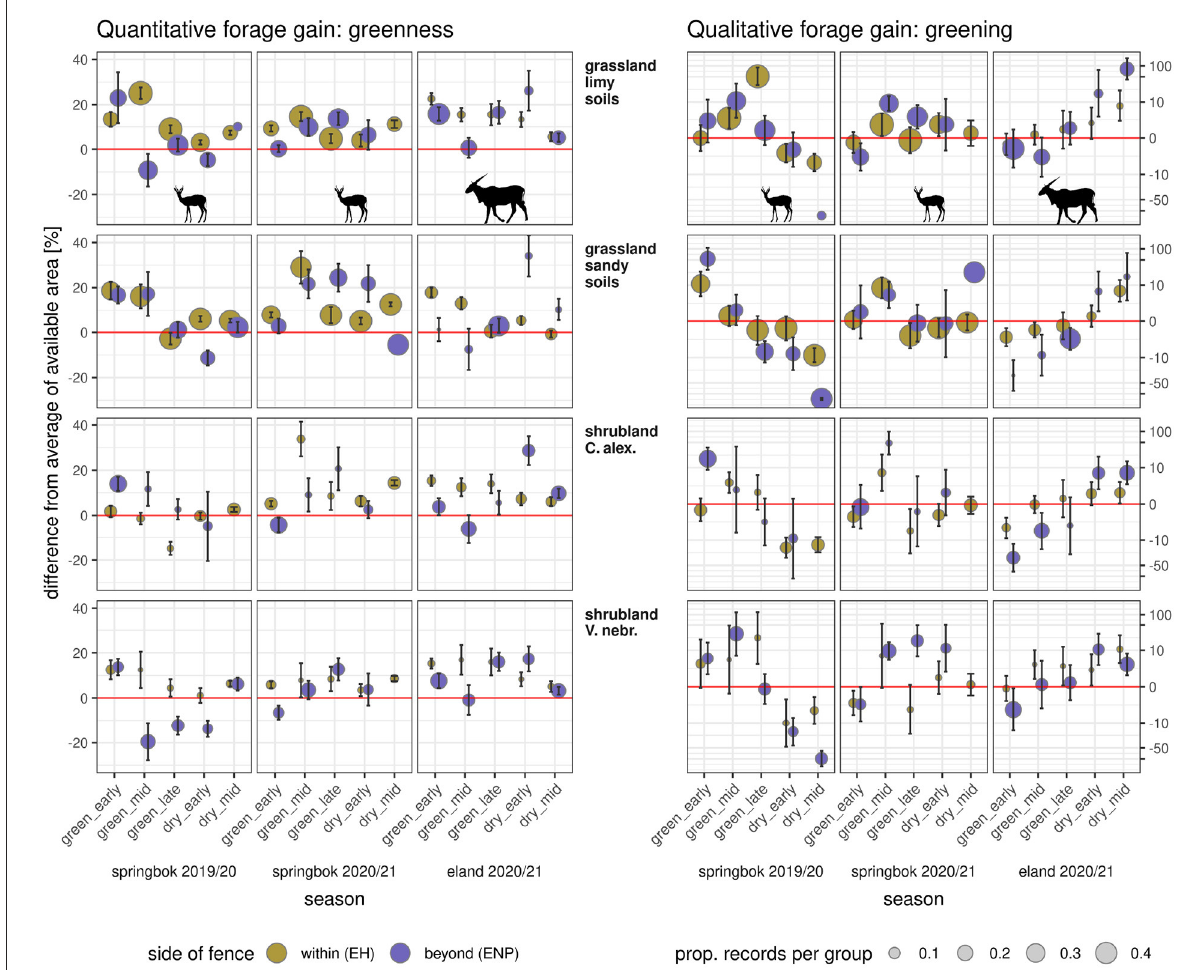
FIGURE5 Gain or loss in forage quality and quantity in relation to the fence side. Species- and season-wise (columns of panels, see column titles on bottom) and vegetation type specific (rows of panels, see row titles; C. alex. , Catophractes alexandri ; V. nebr. . Vachellia nebrownii ; details in Supplementary Figure 2) gains calculated from time series of Sentinel-2 satellite images. Left : gain in MSAVI (or forage quantity) as the difference between mean daily (interpolated) MSAVI at positions and mean daily MSAVI of the available area (individual-wise MCP). Right : gain in MSAVI slope (or forage quality) as the difference between mean daily (interpolated) MSAVI slope at positions and mean daily MSAVI slope of available area (individual-wise MCP). Differences are scaled as percentages of the available area’s mean with algebraic signs kept. Points depict the mean of records per season (x-axis) with standard error (error bars). Positive values indicate a gain and negative values indicate a loss. Point colors refer to location (see legend). Point size is relative to the proportion of observations falling into the respective vegetation type per species and season (see